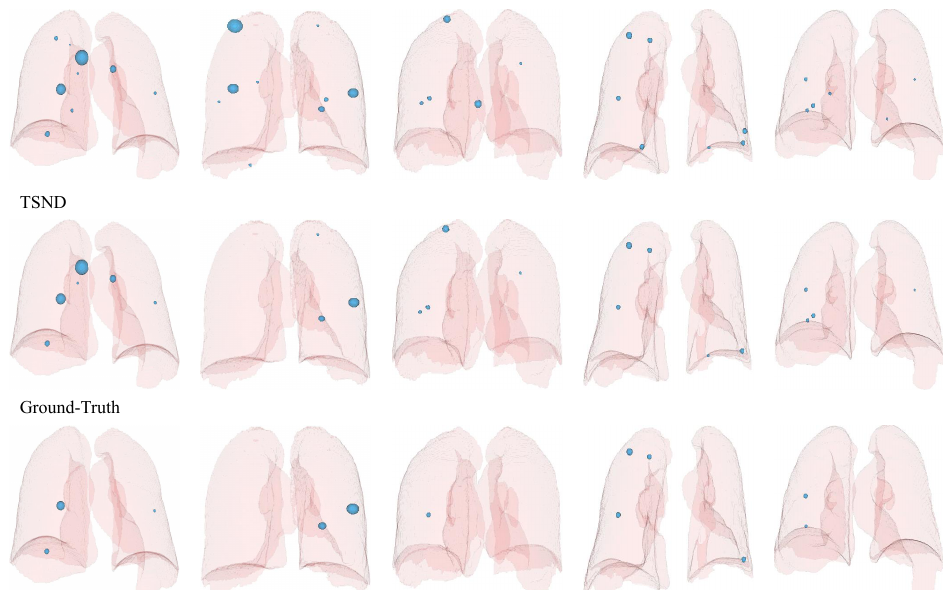
Figure 11. Visualization of candidates (ground-truths) in the 3D lung mask label, where 3D light blue spheres represent predicted candidates (ground-truths). The first two rows indicate the candidates detected by OS-MSFD and TSND, respectively, and the last row is for ground truth supported by the LUNA16